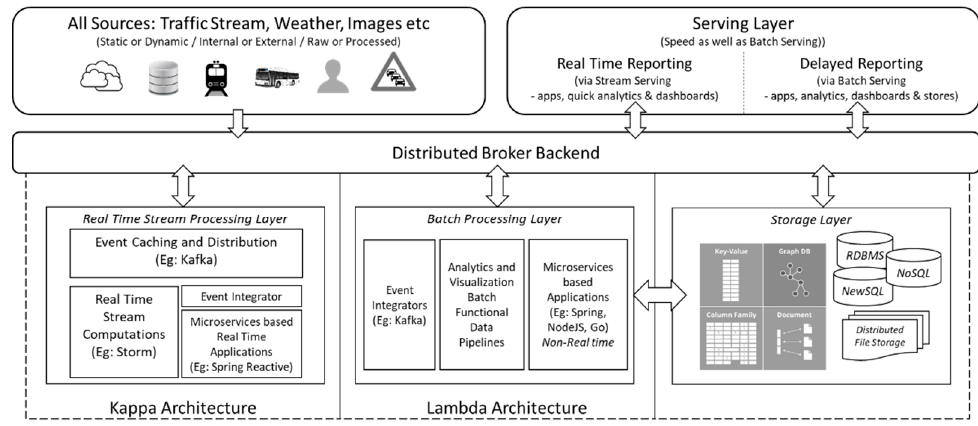
Figure 1. Overview of proposed Microservice-Oriented Big Data Architecture (MOBDA).